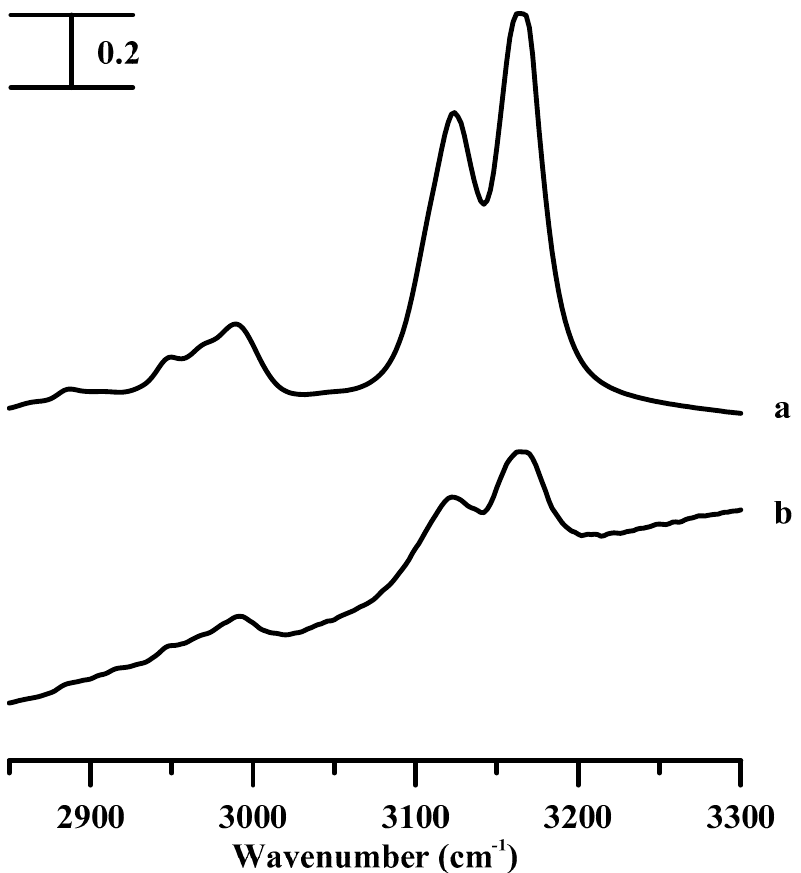
Figure 1. Infrared spectra of the (a) pure [C 2 C 1 Im][BF 4 ] and (b) [C 2 C 1 Im][BF 4 ] in a silica matrix, recorded at ambient pressure.